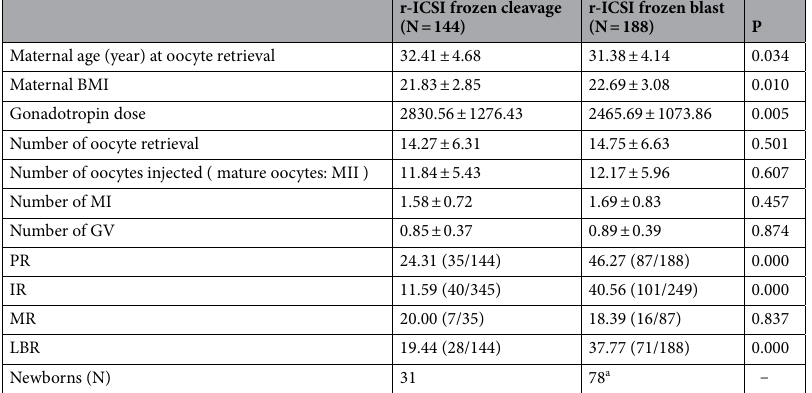
Table 1. Comparisons of patient conditions and outcomes of ET between r-ICSI frozen cleavage and r-ICSI frozen blast. Data are % (n/N) or the mean ± SD. PR: pregnancy rate; IR: implantation rate; MR: miscarriage rate; LBR: live birth rate. a One